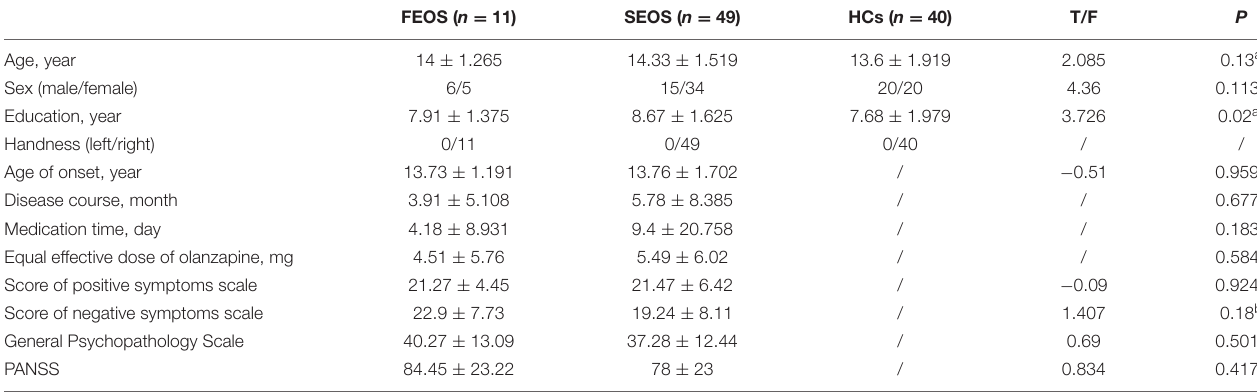
TABLE 2 | Demographic profile of familial early-onset schizophrenia (FEOS), sporadic early-onset schizophrenia (SEOS) and healthy controls (HCs) [values are mean